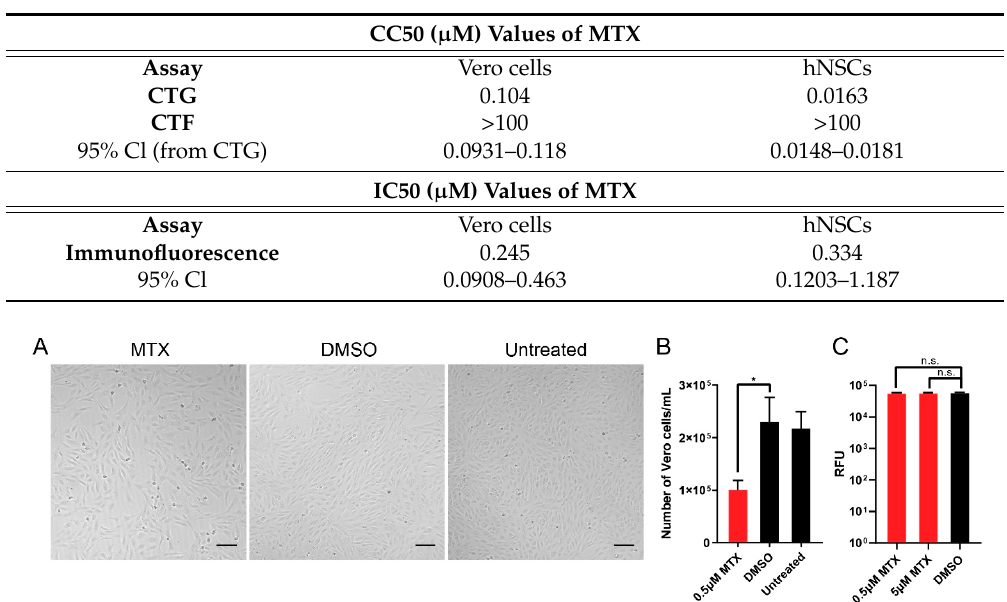
Table 1. Host cytotoxicity (CC 50 ) and effective concentration 50 (EC 50 ) values of MTX in Vero cells and hNSCs. CTG (CellTiter-Glo ® ) measures adenosine triphosphate (ATP) as a luminescent readout of cell viability biomarker. CTF (CellTiter-Fluor™) measures live protease activity as a fluorescent readout of cell viability biomarker. Immunofluorescence images of ZIKV-infected (H/PAN MOI 0.2) Vero cells and hNSCs with MTX in a dose-response manner. Average cytoplasm fluorescence signal (ZIKV envelope protein) was measured per nuclei scoring. At least two independent replicates were performed for each experiment.